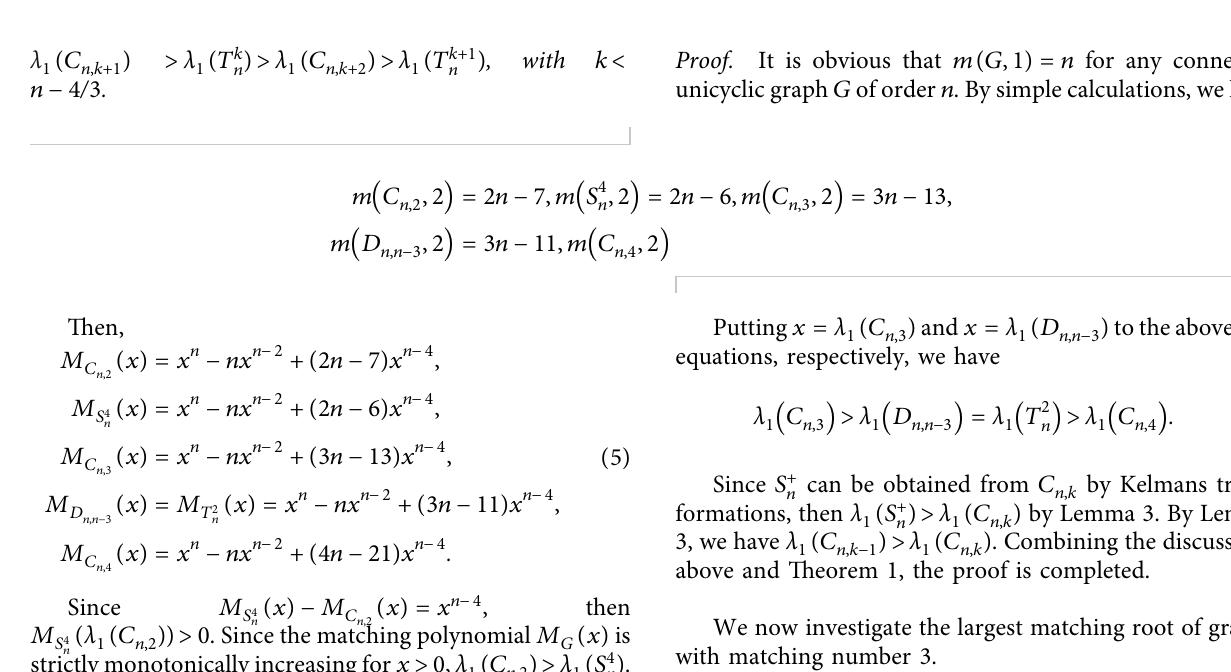
C , S 4 D n,k n,n − 3 , and n , n ,